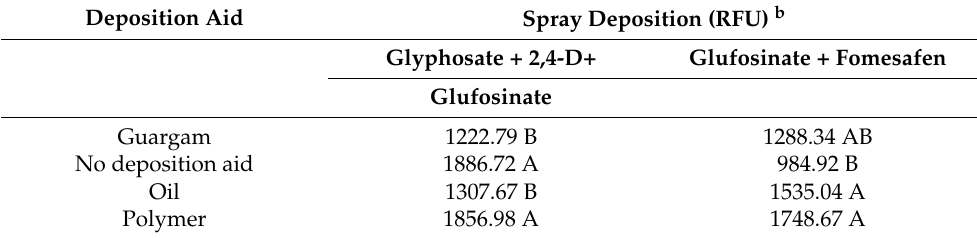
Table 9. Soybean spray deposition a of herbicide solutions tank-mixed with different deposition aids. Data were pooled over years. Means within a column followed by the same letter are not significantly different ( α ≤